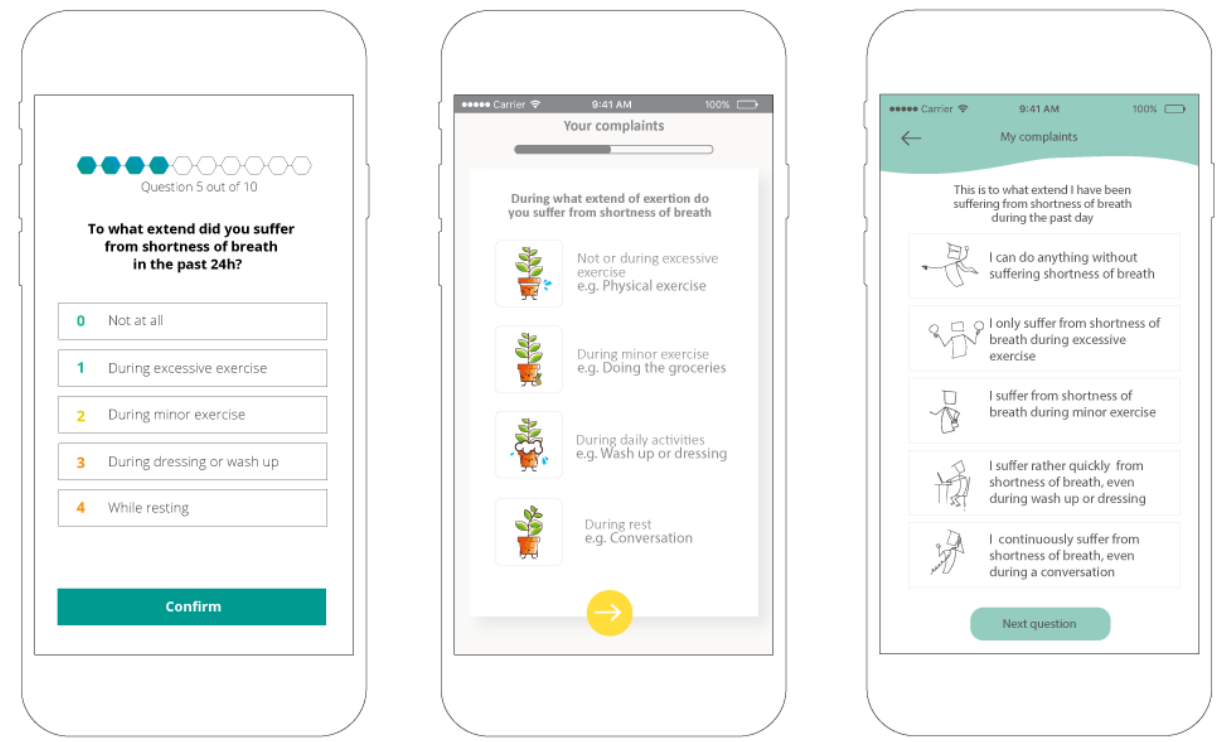
Figure 4. Low-fidelity paper prototypes of three symptom monitoring design